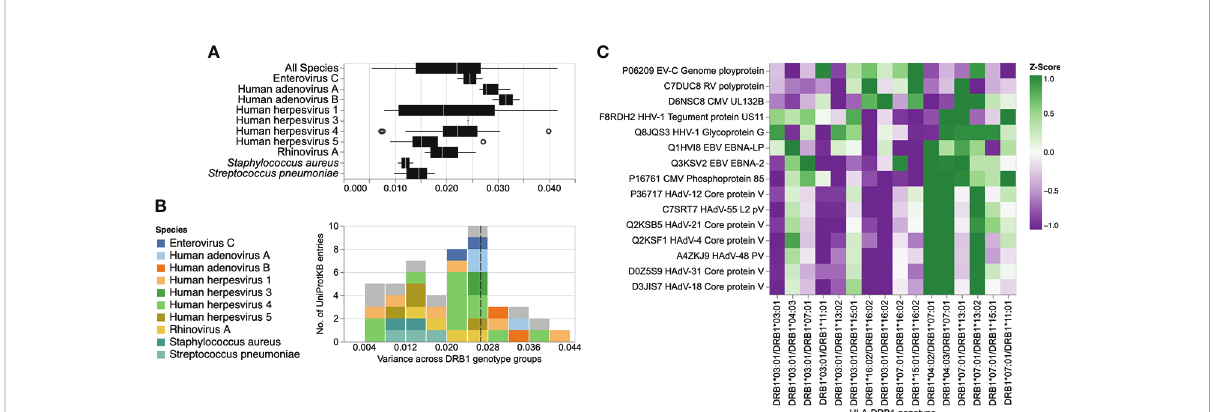
FIGURE 4 Differential enrichment analysis of antigenic peptide-antibody interactions among different HLA-DRB1 groups. (A) Box plot illustrating the distribution of variance in the mean peptide enrichment frequency per UniProtKB entry of all, or selected, microbial species, and across different HLA-DRB1 genotype groups. (B) Histogram of variance in the mean peptide enrichment frequency per UniProtKB entry, as shown in (A) . High variance captures protein antigens of microbial species that exhibit a comparatively different peptide enrichment pro fi le across HLA-DRB1 genotype groups. The dashed line in (B) indicates the boundary of the upper 25 th percentile (variance ≥ 0.026). UniProtKB entries for which the antibody-antigen interactions showed the highest variance across different DRB1 groups are color-coded by species. (C) Heatmap showing the antibody binding pro fi le of selected microbial antigens across different HLA-DRB1 groups, with hierarchical clustering. Each row is a protein (UniProtKB entry) with a variance ≥ 75% quantile in the mean peptide enrichment frequency as shown in (B) ; each column represents a HLA- DRB1 genotype group. The color gradient represents the mean enrichment score (Z-score) of antigenic peptides per protein antigen and HLA- DRB1 genotype